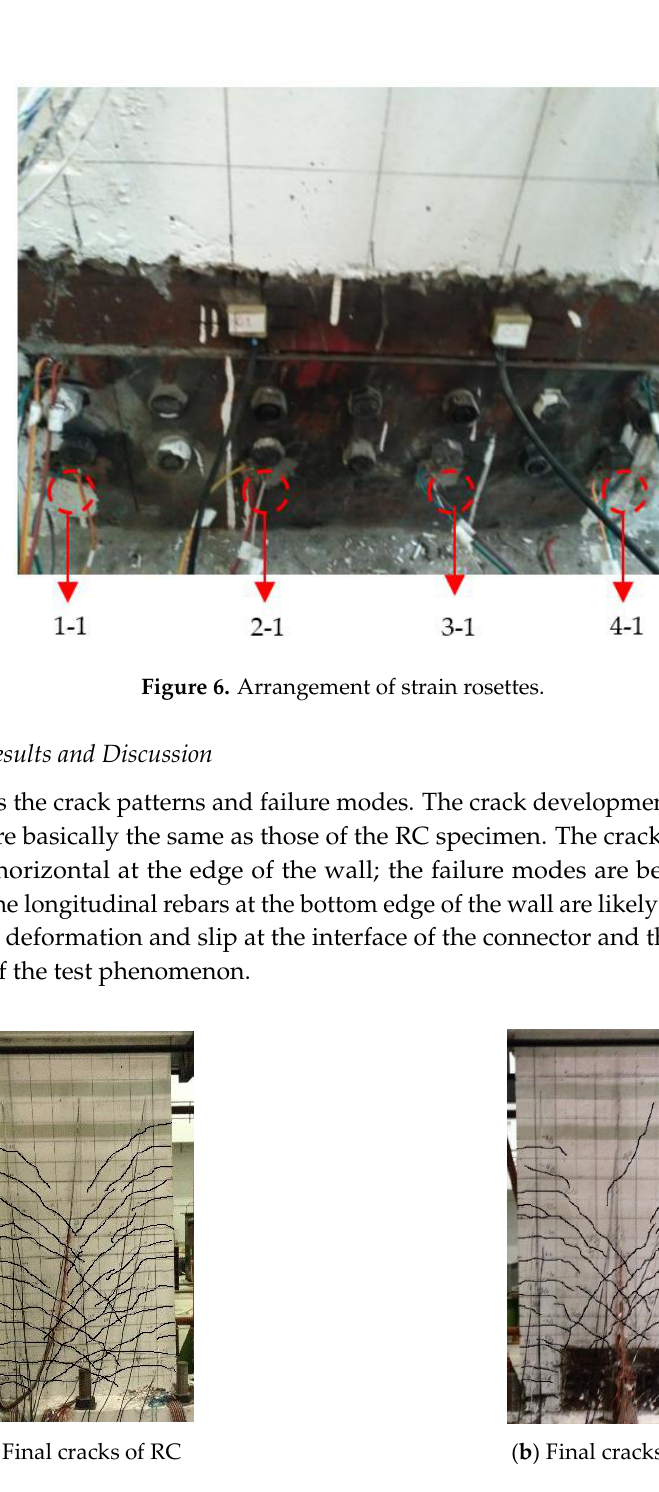
Figure 7. Failure modes of specimens.